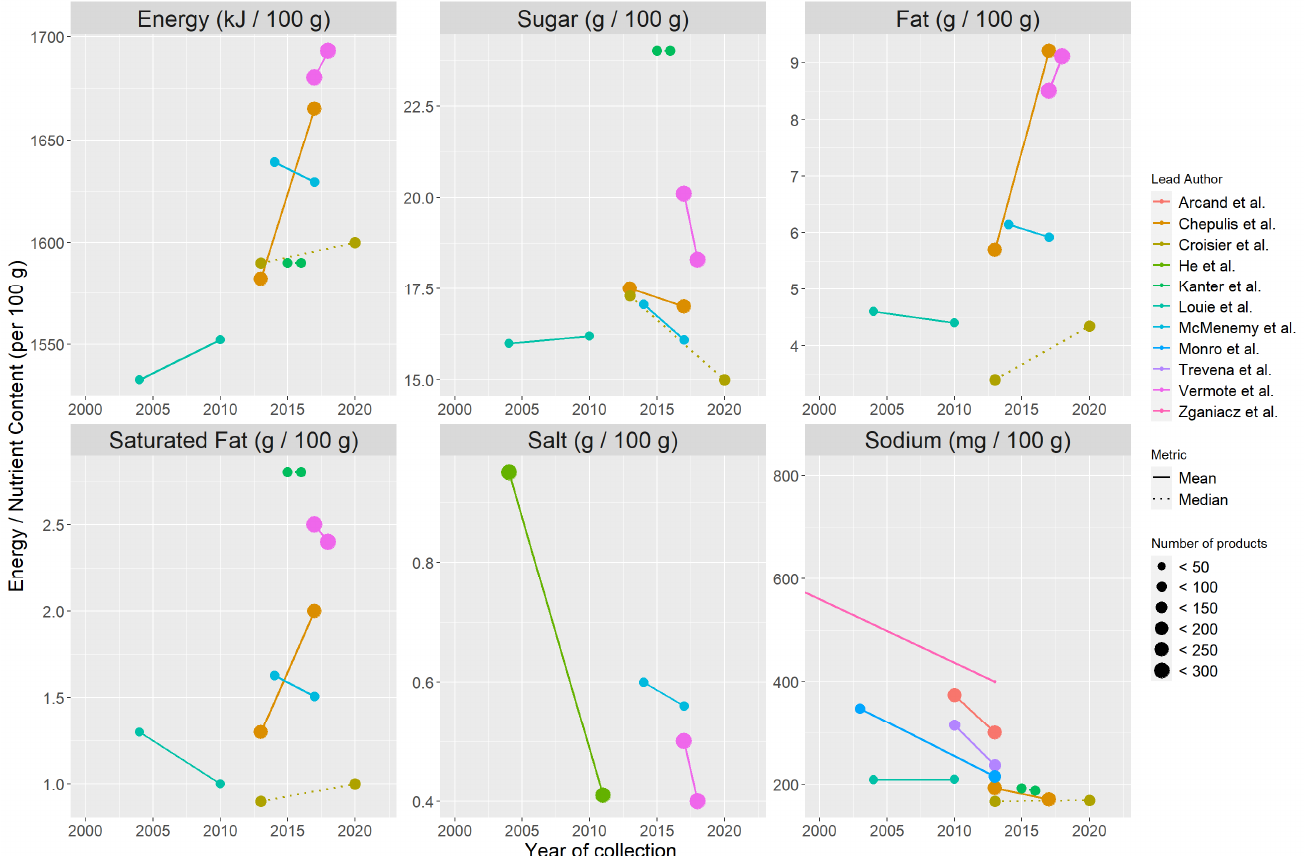
Figure 2. Energy (kJ) and nutrient changes in eligible studies (n = 11) investigating the reformulation of breakfast cereals over time [27,39–47,49].